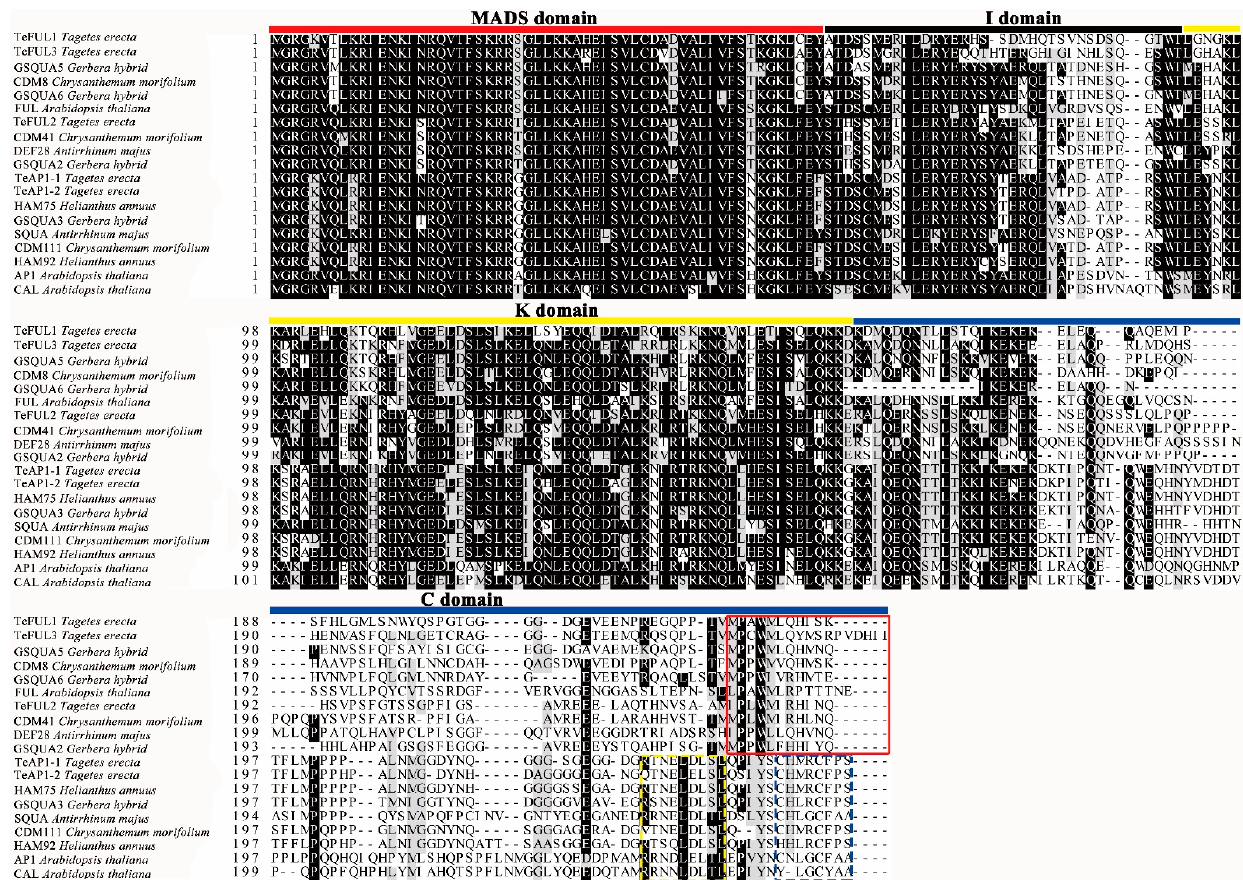
Figure 1. Alignment of marigold AP1/FUL-like amino acid sequence from model plants (Arabidopsis and Antirrhinum) and Asteraceae species. The MADS domain is marked with a bold red line. The I domain is marked with a bold black line. The K domain is marked with a bold yellow line. The C domain is marked with a bold blue line. The FUL protein motif is marked with a red box. EuAP1-like proteins contain both an acidic domain (shown in yellow dotted box), and a farnesylation motif (shown in blue dotted box) at their C termini. The whole domain marked with a red dotted line represents the euAP1 motif.